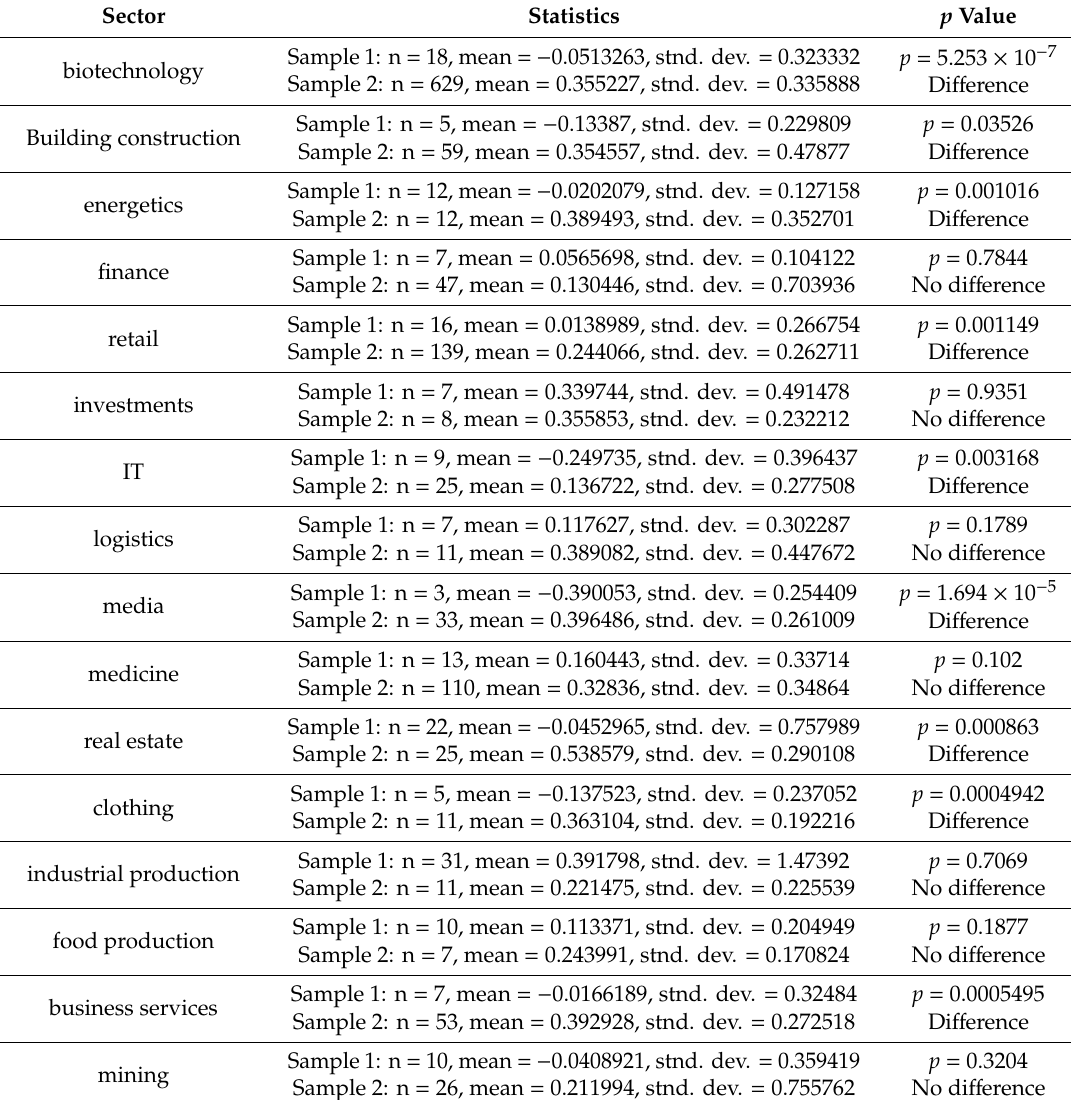
Table 7. Results of mean di ff erence testing in each sector (H0: mean = 0) 3 . Sector